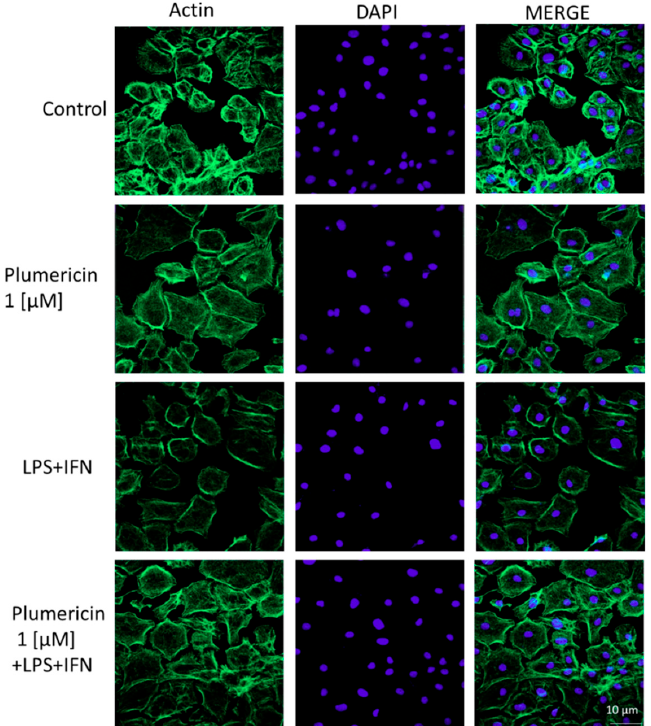
Figure 2. Effect of plumericin (1 µ M) on the actin stress fibers assembly in IEC-6 cells. Immunofluo- rescence analysis was performed using immunofluorescence confocal microscopy. Scale bar = 10 µ m. Green fluorescence indicated the localization of actin stress fibers and blue fluorescence indicated the localization of nuclei (DAPI). The MERGE indicates an overlap of the two